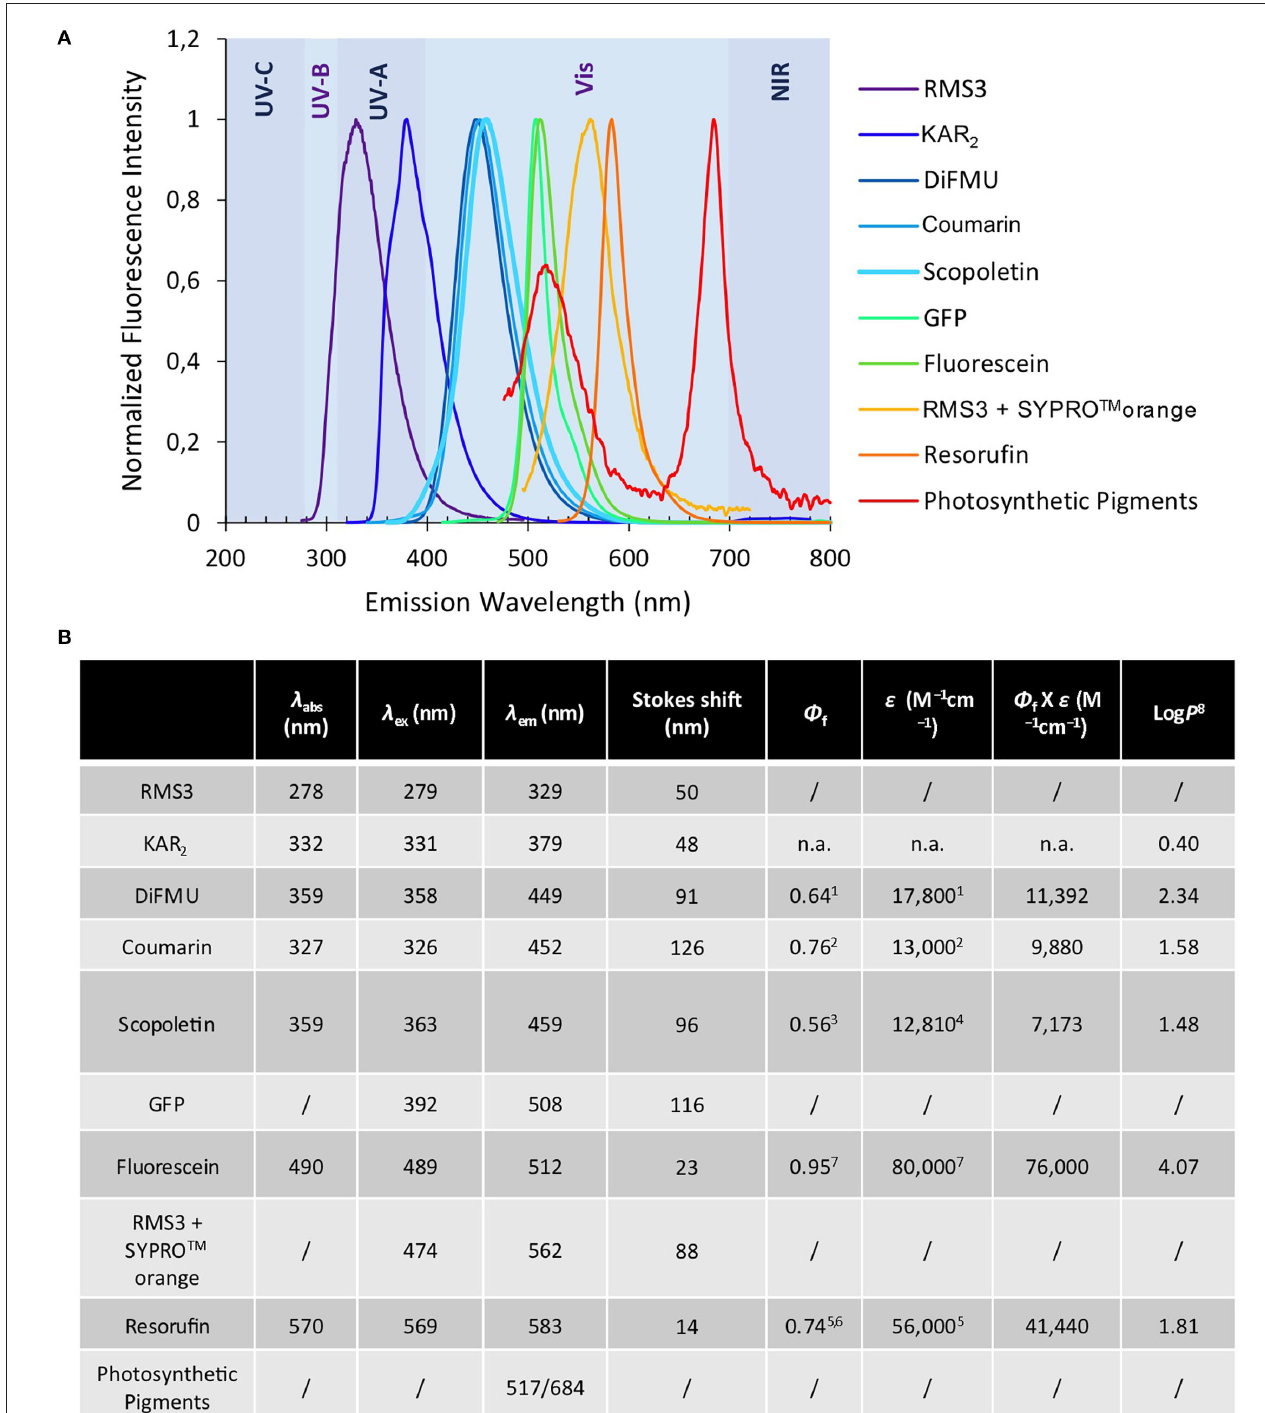
FIGURE 3 | Optical properties of fluorophores. Normalized fluorescence emission spectra of the fluorophores and some chemical compounds (A) (mentioned in this study). Chemical and spectral data for each molecule as λ abs (nm) λ ex (nm) λ em (nm) ε (M − 1 cm − 1 ) Φ f Φ f X ε (“molecular brightness”) (M − 1 cm − 1 ) Log P (B) 1 pH 10 (Sun et al., 1998). 2 pH 7.4 (Setsukinai et al., 2000). 3 pH 6.8 (Pham et al., 2019). 4 In EtOH (Abu-Eittah and El-Tawil, 1985). 5 pH 9.5 (Tan et al., 2021). 6 (Bueno et al., 2002). 7 In 0.1N NaOH, https://www.aatbio.com. 8 Log P are calculated by the ACD program. n.a. not available.